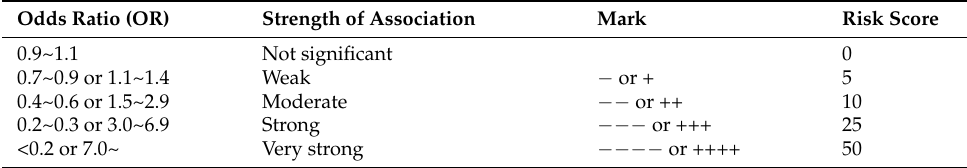
Table 2. Classification of individual cerebrovascular disease risk levels.